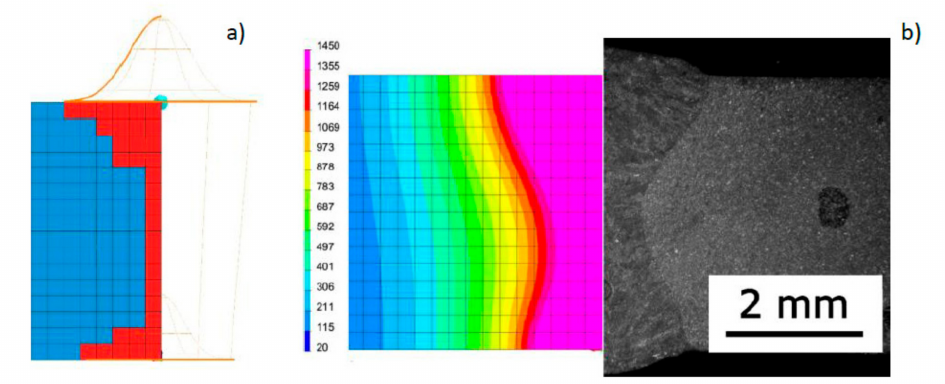
Figure 15. View ( a ) of the method of loading the mesh elements and placement of the conical model of the heat source, comparing ( b ) the shape of the DL1.5_8.33 bead on the cross-section with the results of numerical analysis (Table 1, Figure